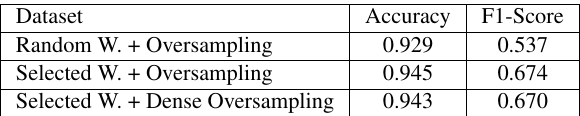
Table 4. Performance of the proposed oversampling approach.